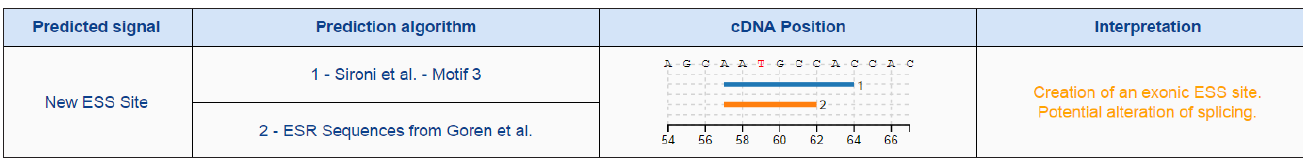
Figure 2. Output of HSF algorithms prediction for Asn352= impact on splicing process Table 2. PROVEAN and PolyPhen2 prediction results for identified missense variants Variant